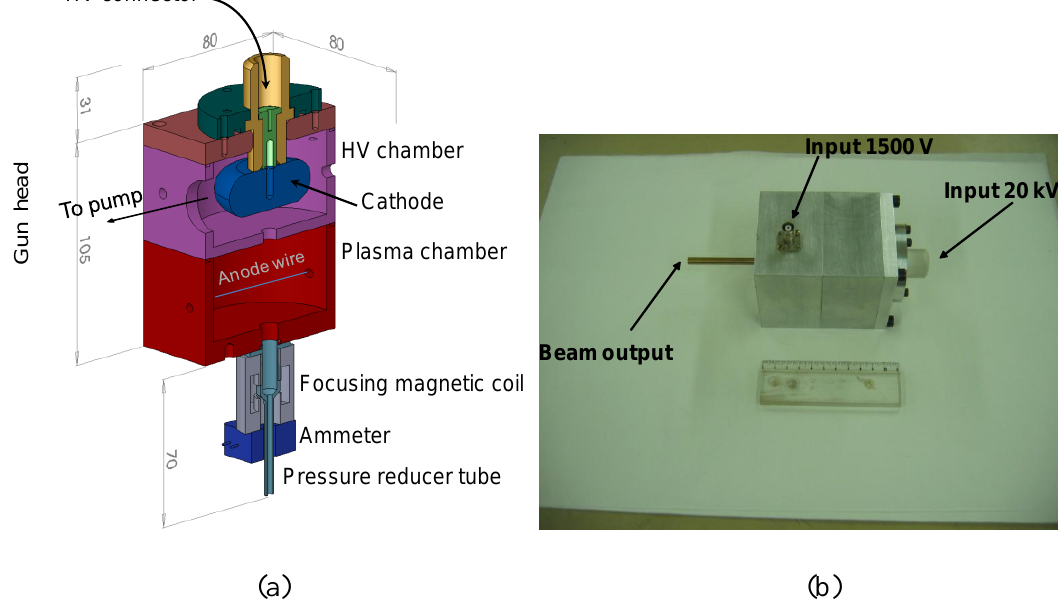
Figure 2. Electron gun head. (a) Electron gun head (all dimensions in mm). (b) Photography of the gun head (matched to a 110 mm long